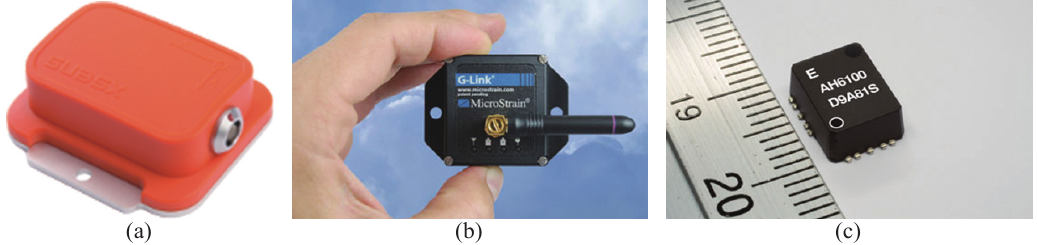
Fig. 13. Examples of MEMs (a) Xsens, (b) MiocroStrain, Inc (c) Epson Toyocom